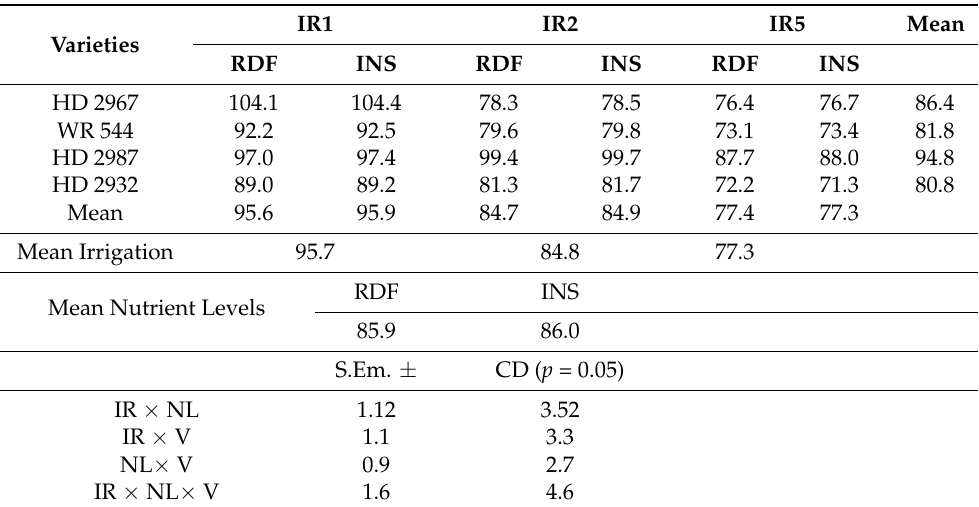
Table 5. Interaction effect of nutrient management levels, irrigation schedules, and varieties on dehydrogenase ( µ g TPF/g soil/d).